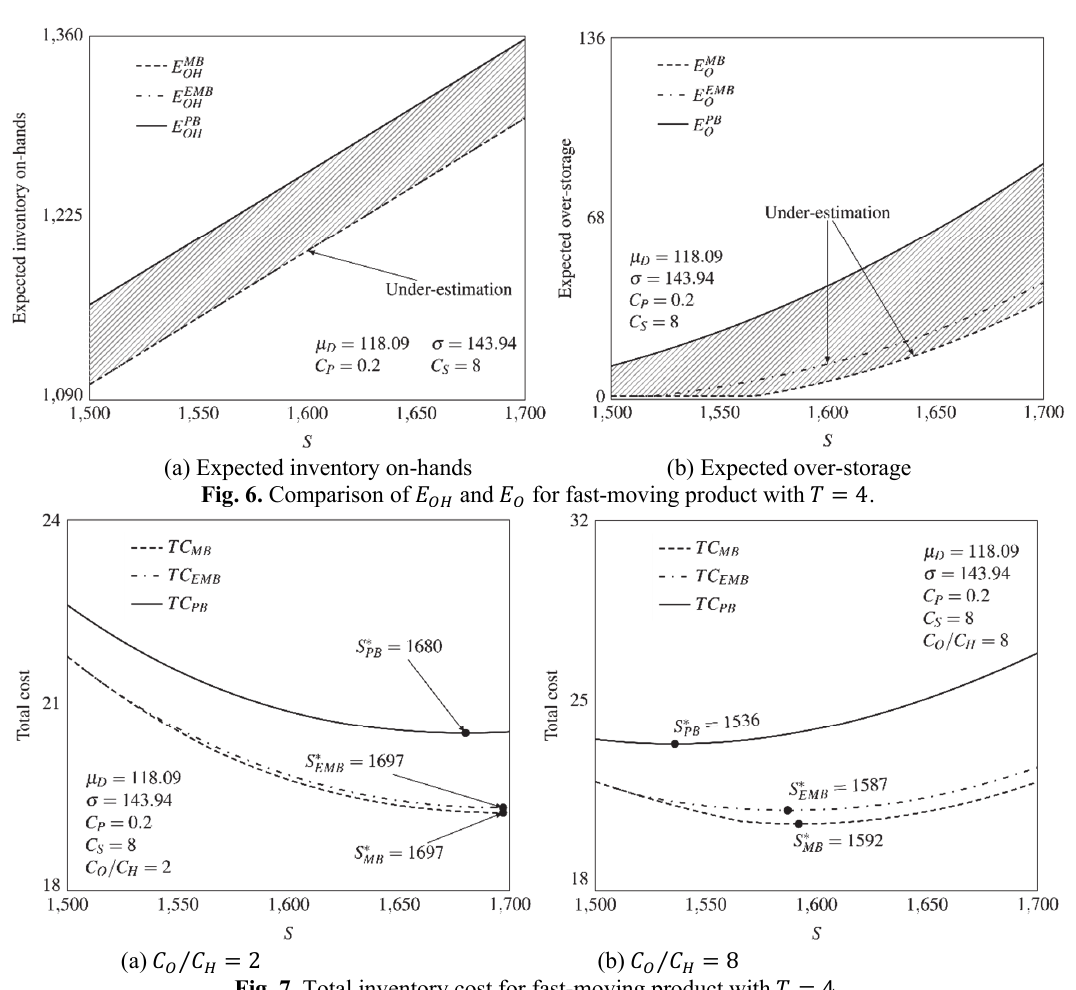
Fig. 7. Total inventory cost for fast-moving product with 𝑇 = 4